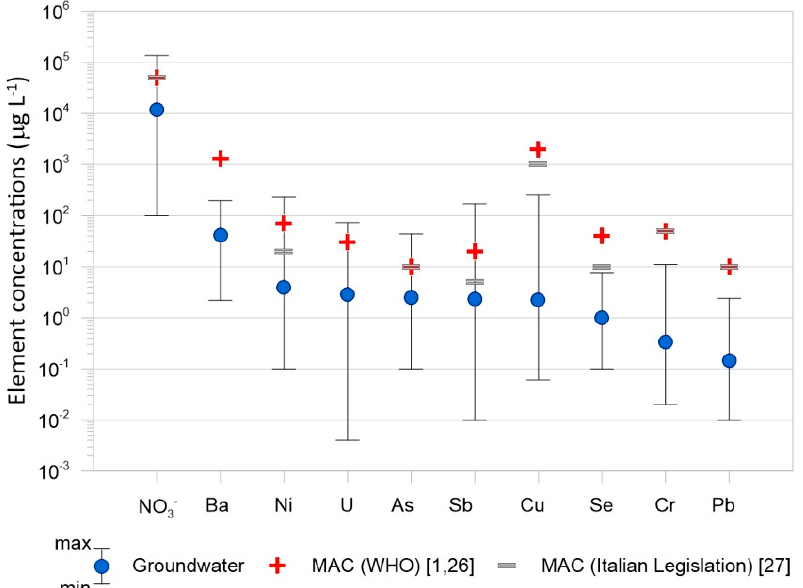
Figure 3. The mean values of trace element concentrations in groundwater (blue dots); vertical black lines indicate related minima and maxima. Red crosses represent the Maximum Admitted Concentrations (MAC) established by the WHO [1,35] for drinking water, while grey dashes the limits established by the Italian National Legislative Decree 31/2001 (2 February 2001) [36].